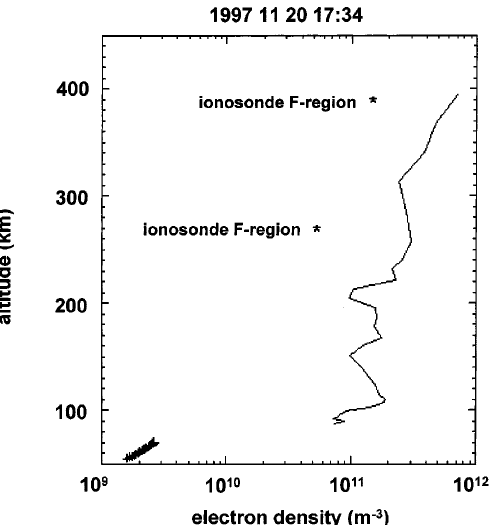
Fig. 8. All plasma density measurements for the launch of ISBJØRN I on 20 November, 1997. The solid line represents the ESR measurement; the dotted line represents the ISBJØRN I measurement and the two stars the ionosonde measurement